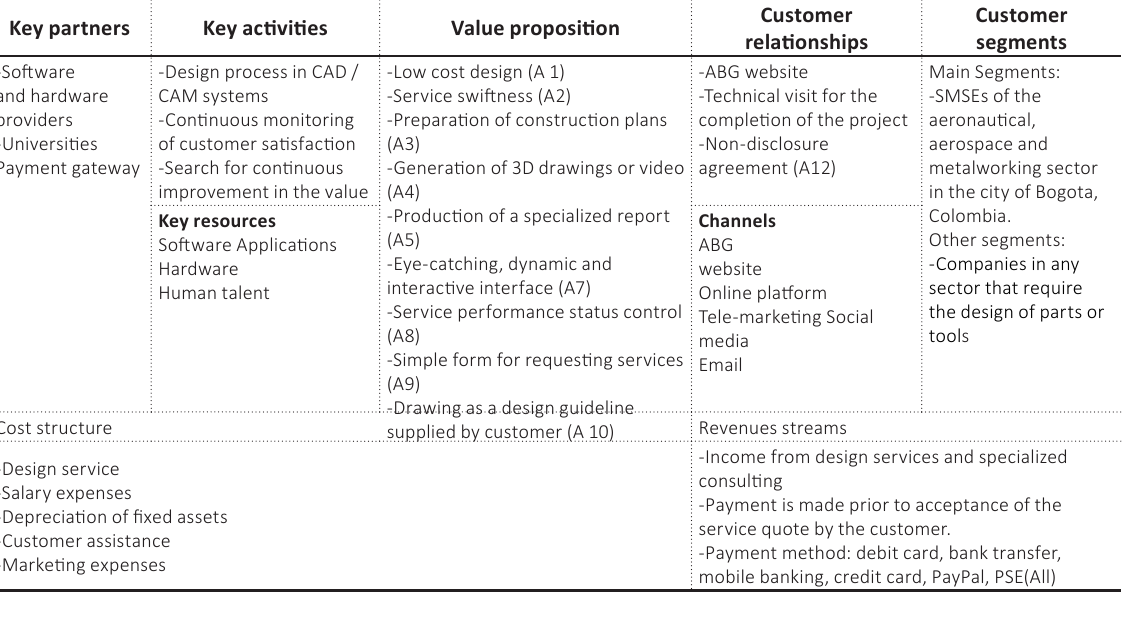
Table 5. Business model of NON-LIFE insurance companies according to the National